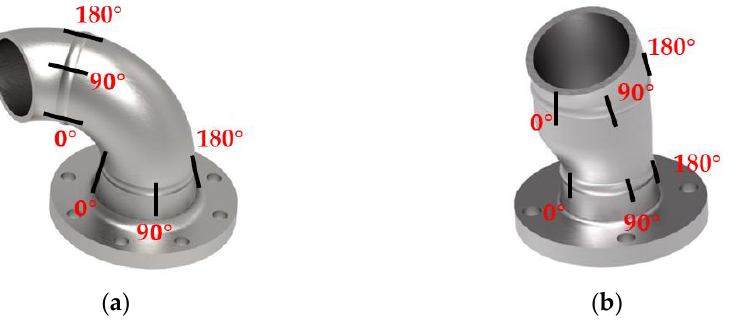
Figure 20. Angles for each inspection position on the experimental welding test pieces: ( a ) 100 mm curvature pipe with elbow – flange construction geometry; ( b ) 75 mm, 100 mm curvature pipe with elbow – flange – reducer construction geometry.